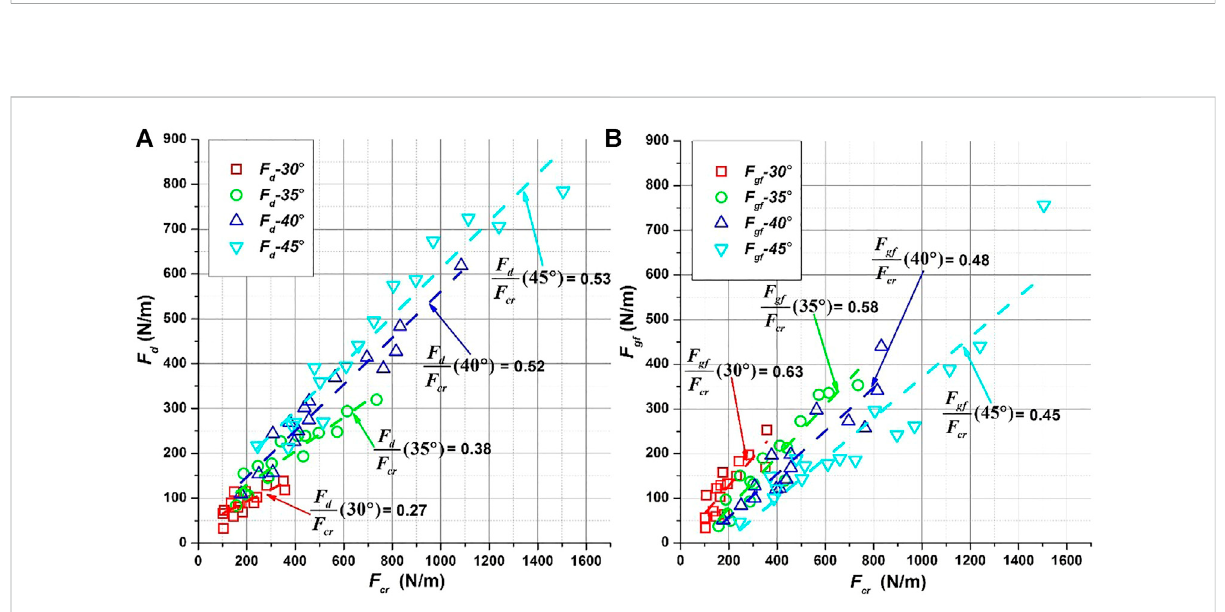
FIGURE 8 Dominant force component variation with inclination